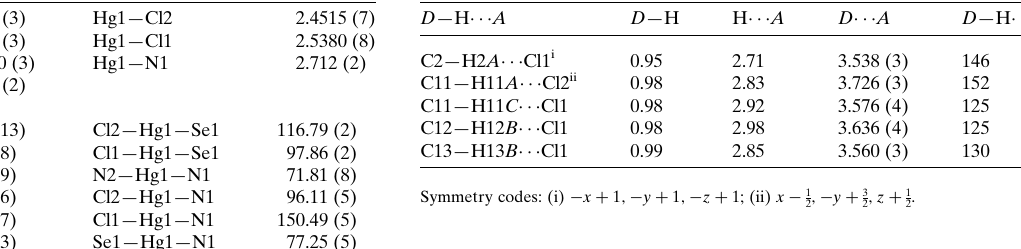
Table 2 Hydrogen-bond geometry (A˚ , (cid:4) ).